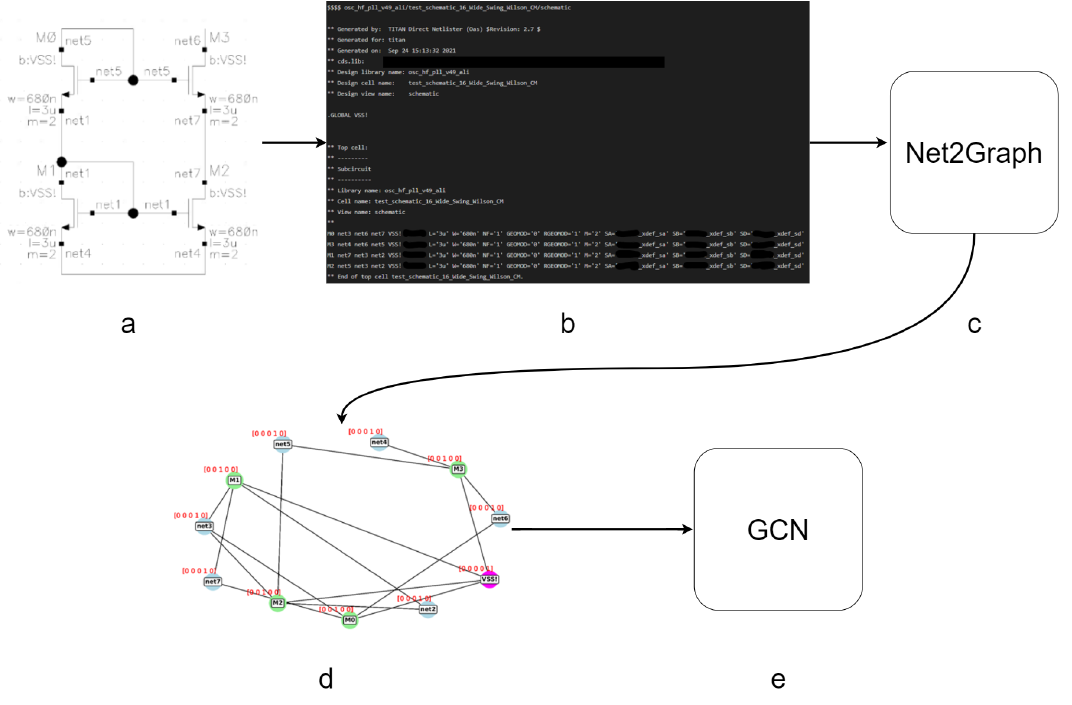
Figure 5. System overview: a pipeline for one sample classification using GCN. ( a ) Input schematic, ( b ) the schematic is converted to Spice netlist using Cadence Virtuoso, ( c ) Spice netlist parser, ( d ) the parser is used to convert the netlist into a graph, ( e ) GCN is the chosen neural network model to perform the